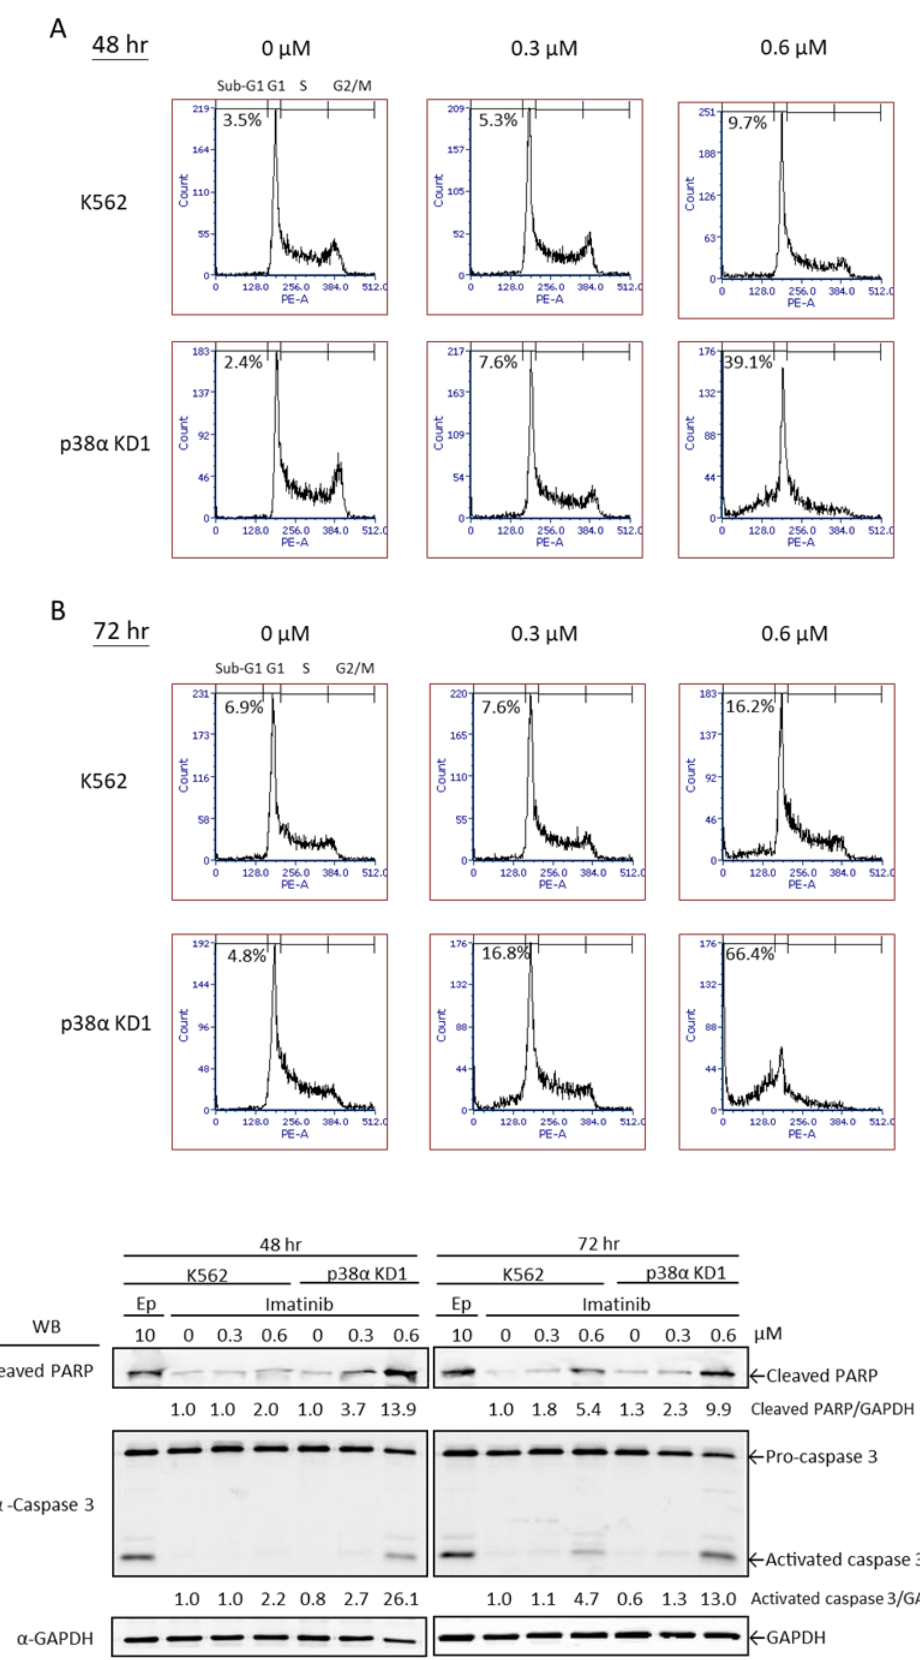
Figure 3. Imatinib-induced apoptotic cells death significantly increased when p38 α was deficient. The K562 parental and p38 α -knockdown (KD1) cells were treated with various concentrations of imatinib as indicated for 48 and 72 h. Cells were